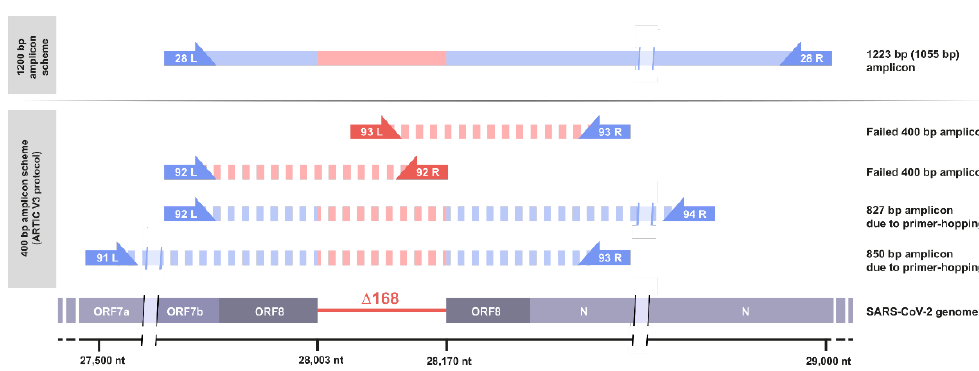
Figure 2. Schematic view on the ORF8 gene region and the respective amplicons using different amplification protocols. Amplicon 28 of the amplicon scheme by Freed et al. [15], using 1200 bp amplicons, is shortened to 1032 bp in the ∆168 variant (top). Amplicons 92 and 93 of the ARTIC-V3 amplicon scheme fail due to the deletion of primer-binding sites. However, more distant primer-pairs may interact and lead to longer amplicons spanning the ∆168 deletion, thus enabling sequencing using the ARTIC-V3 protocol.